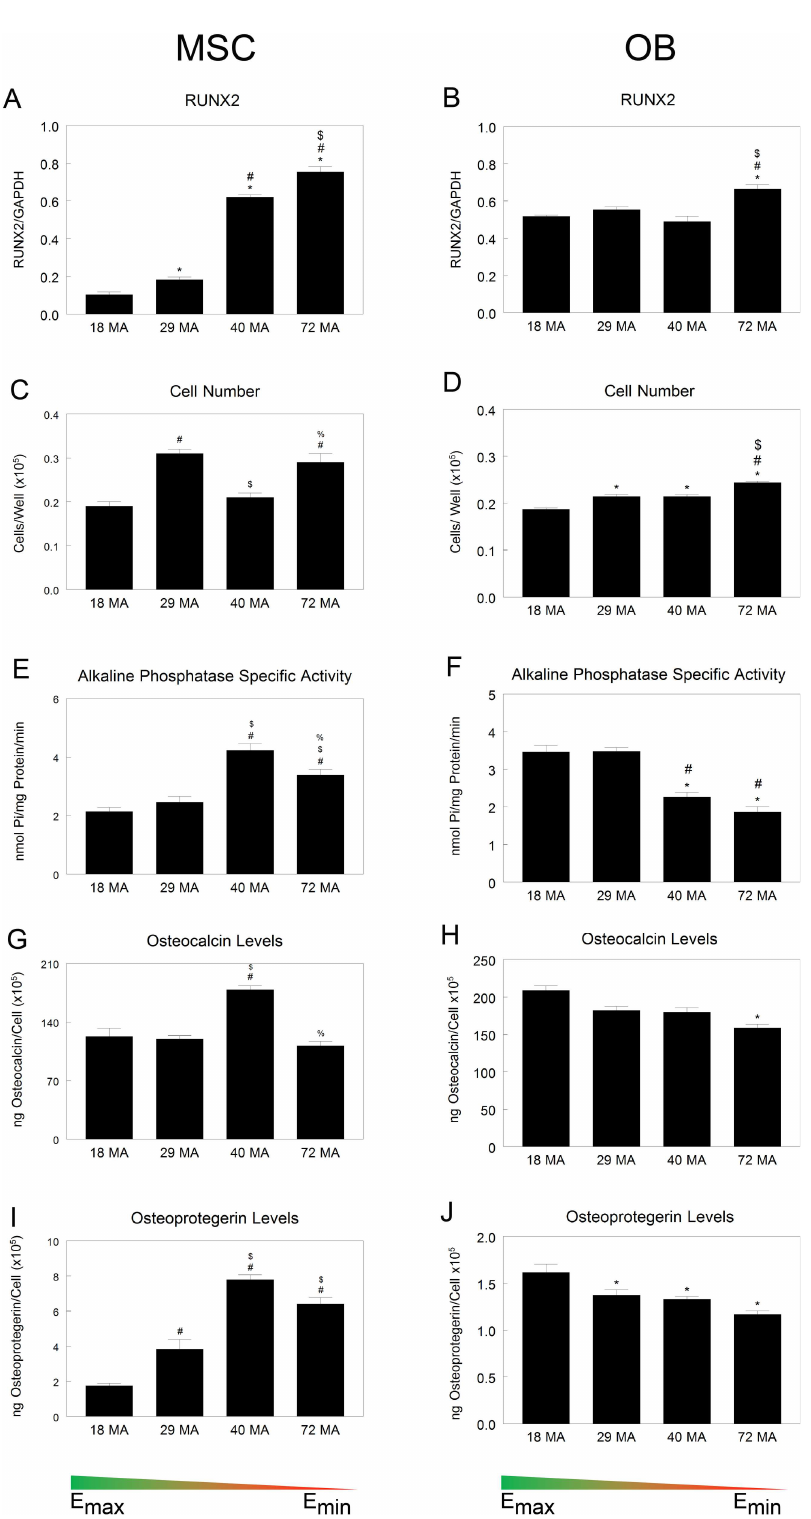
Fig 4. Osteoblastic differentiation on MA-MMA networks. (A-B) mRNA levels for osteoblast-specific marker RUNX2. (C-J) MSC and HOB responseto substrate stiffness seen in cell numberand osteogenic protein levels. * P < 0.05 vs. 18 MA, # P < 0.05 vs. 29 MA, $ P < 0.05 vs. 40 MA.